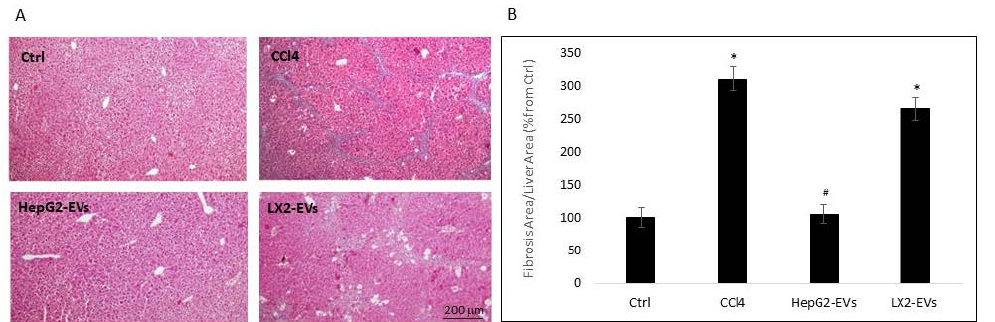
Figure 6. The effectof LX2and HepG2 EVson liverfibrosis in-vivo. ( A ) Representative Masson’strichrome staining of mouse liver tissue following EV treatment described in Figure 5 legend. Using ImageJ software liver images were analyzed and the relative area of the fibrosis were measured. ( B ) Quantitative analysis of the liver fibrosis area, calculated as mean percent fibrotic area relative to that of the sham group. Results are expressed as mean ± SEM. * Significantly higher than sham; # Significantly lower than CCl4, p < 0.05 (ANOVA with a post-hoc Bonferroni-adjusted Student’s t